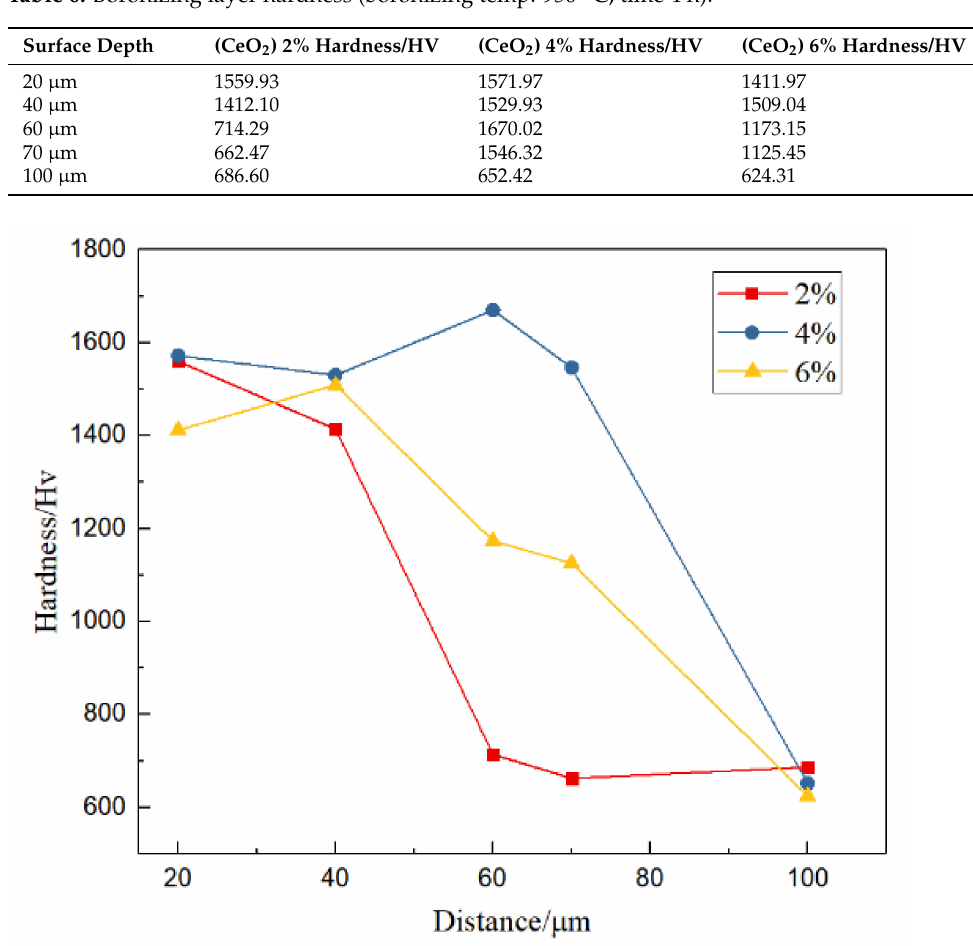
Figure 2. Hardness curves of different rare earth CeO 2